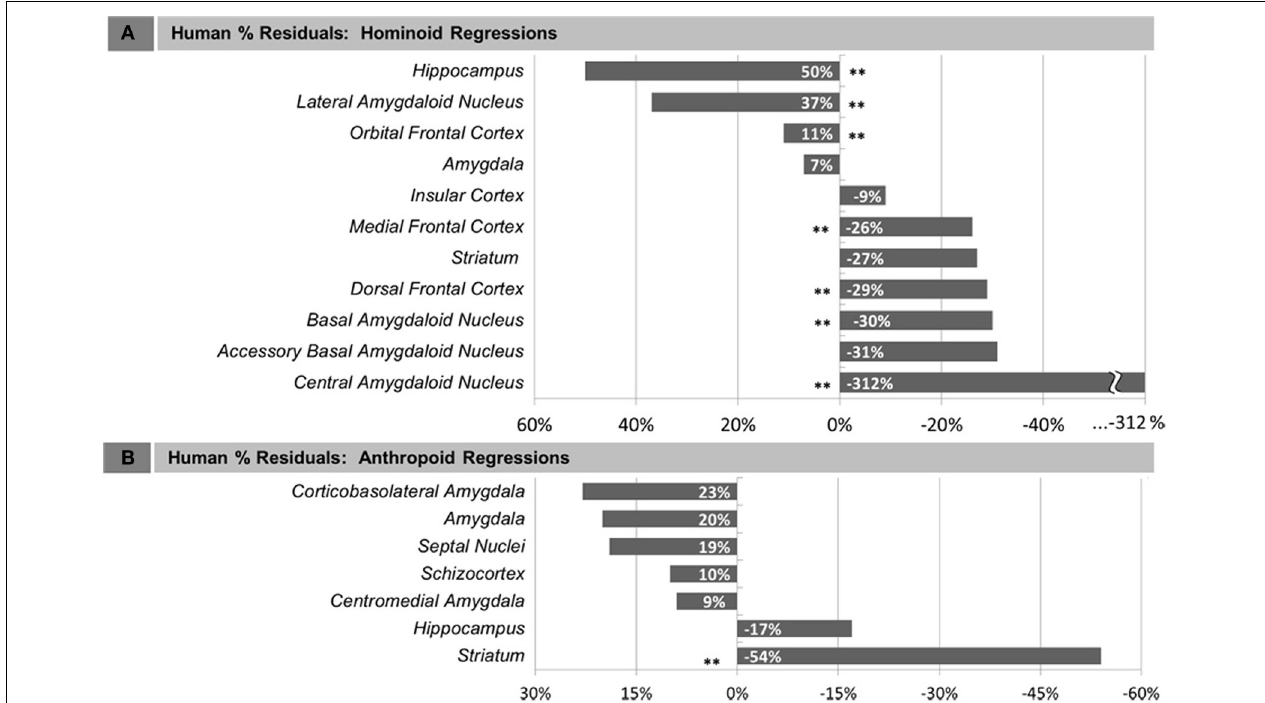
FIGURE 3 | Human percent residual deviations from non-human regression lines for: (A) Human comparisons with other hominoids and (B) human comparisons with other anthropoids. Asterisks ( ∗∗ ) indicate